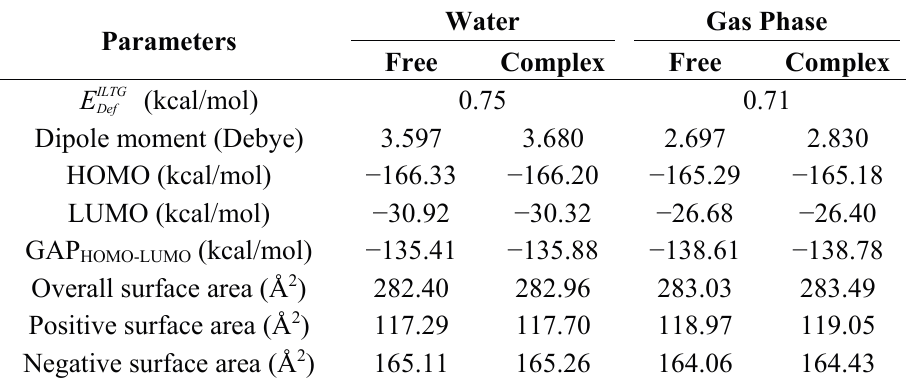
Table 3. Quantum-chemical descriptors of ILTG before and after forming the inclusion with G 2 - β -CD at the B3LYP/6-31+G(d) level of